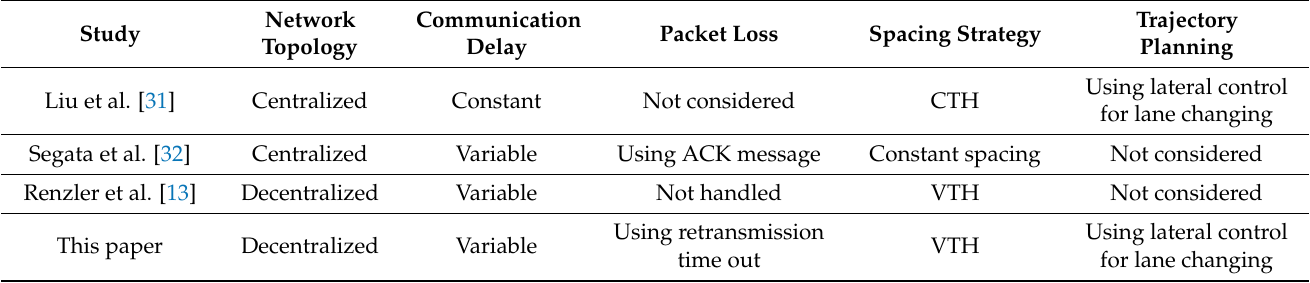
Table 1. Comparison of join-in-middle maneuver